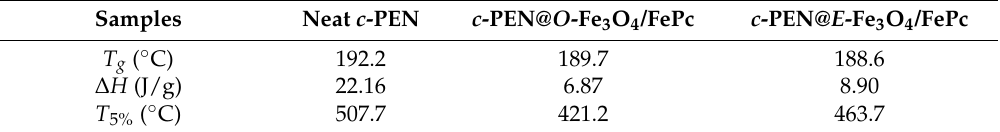
Table 1. The glass transition temperature ( T g ), melt enthalpy ( ∆ H ), and initial